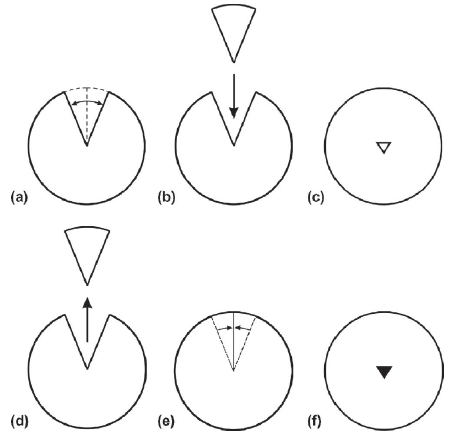
Figure 15. Volterra cut for a negative wedge disclination, where material is inserted ( a – c ), and alternative Volterra cut for a positive wedge disclination, where material is removed ( d – f ). Figure and caption reprinted from Müllner and King [102] with permission from Elsevier.